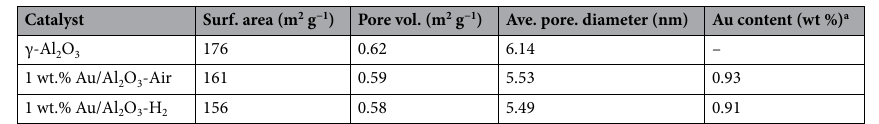
Table 1. Textural properties of γ-Al 2 O 3 and γ-Al 2 O 3 supported nano Au catalysts. a Based on ICP-OES analysis.